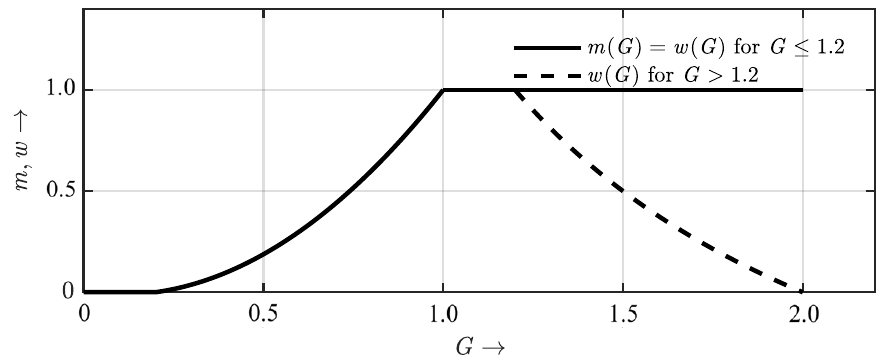
Figure 3. Functions m ( G ) and w ( G ) according to [1] and after